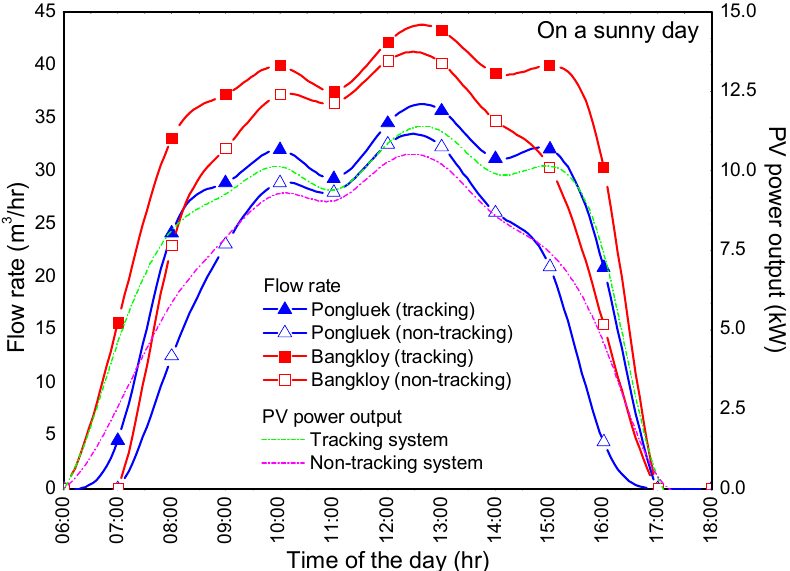
Figure 14. Water flow rate of the pumps at Pongluek and Bangkloy according to the PV power output on a sunny day for tracking and non-tracking SWSS.